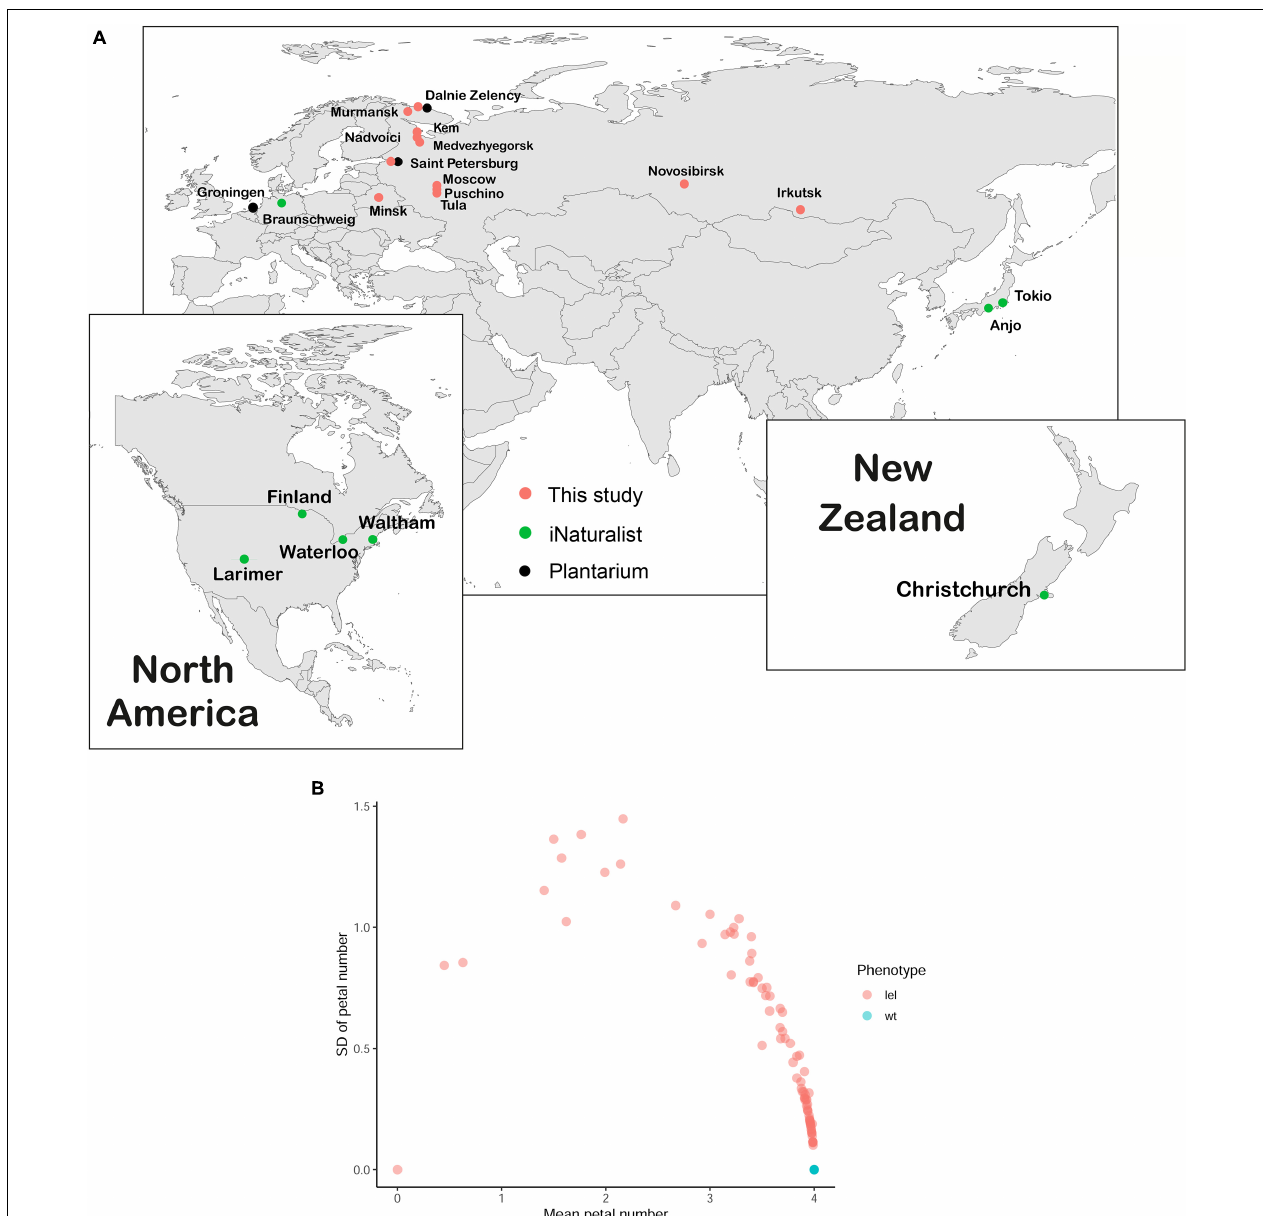
FIGURE 3 | Geographical distribution and phenotype variance of apetalous C. bursa-pastoris . (A) The geographical distribution of lel variety, mapped using database exploring (Plantarium and iNaturalist) and field search. Each dot represents a single location where apetalous C. bursa-pastoris was found. (B) The dependence of SD of petal number on average petal number. For each plant, petals were counted in each flower on the main and secondary inflorescence axes, and then, average and SD were calculated for every plant. Each dot represents one plant; it is noted that all wild-type plants